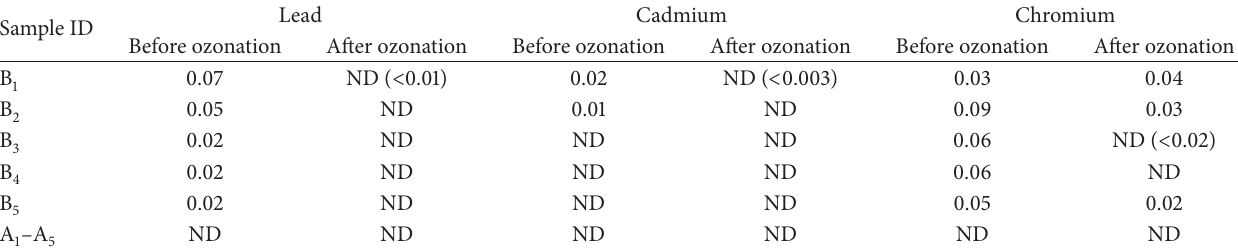
Table 2: Concentrations of lead, cadmium, and chromium before and after treatment by